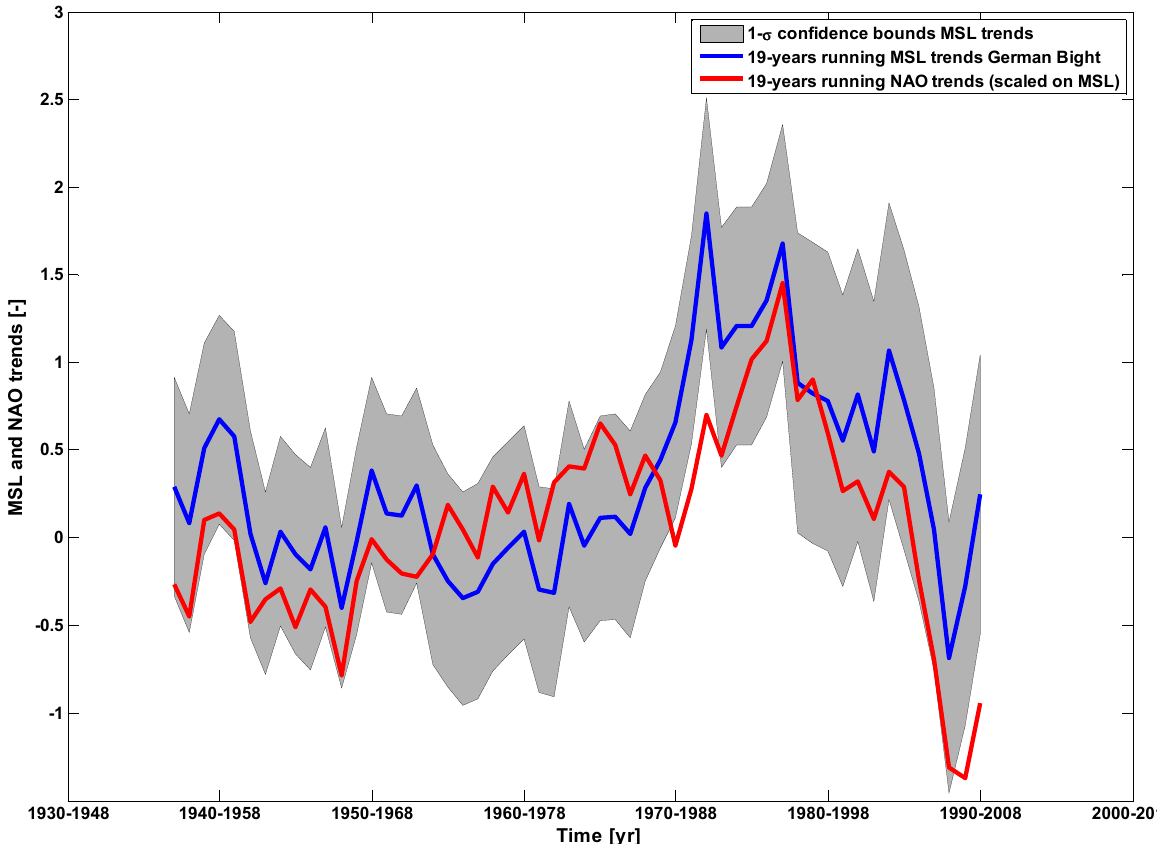
Figure 8. 19-year running linear trends of swMSL (blue line) at the virtual station German Bight and swNAO (red line) for the period from 1937 to 2008. The grey-filled area indicates the 1 − σ confidence bounds for the linear trends estimated by linear